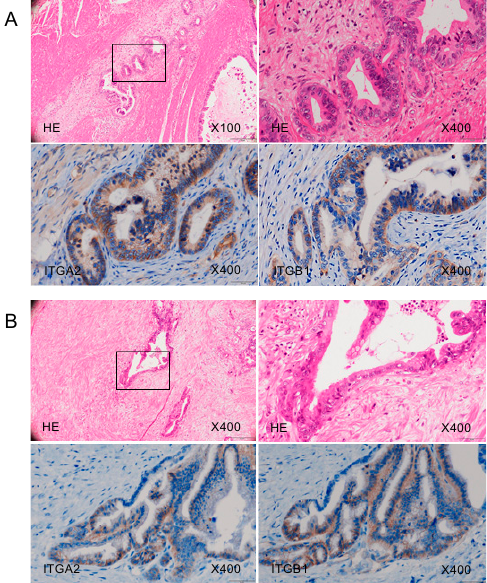
Figure 9. ITGA2 overexpression in clinical PDAC specimens. Representative immunohistochemical images with staining of ITGA2 and ITGB1 in clinical samples. Overexpression of ITGA2 and ITGB1 was detected in the cancer lesions. Images of samples from Patient ( A ) number 20 and ( B ) number 17 (Table S1) are shown.